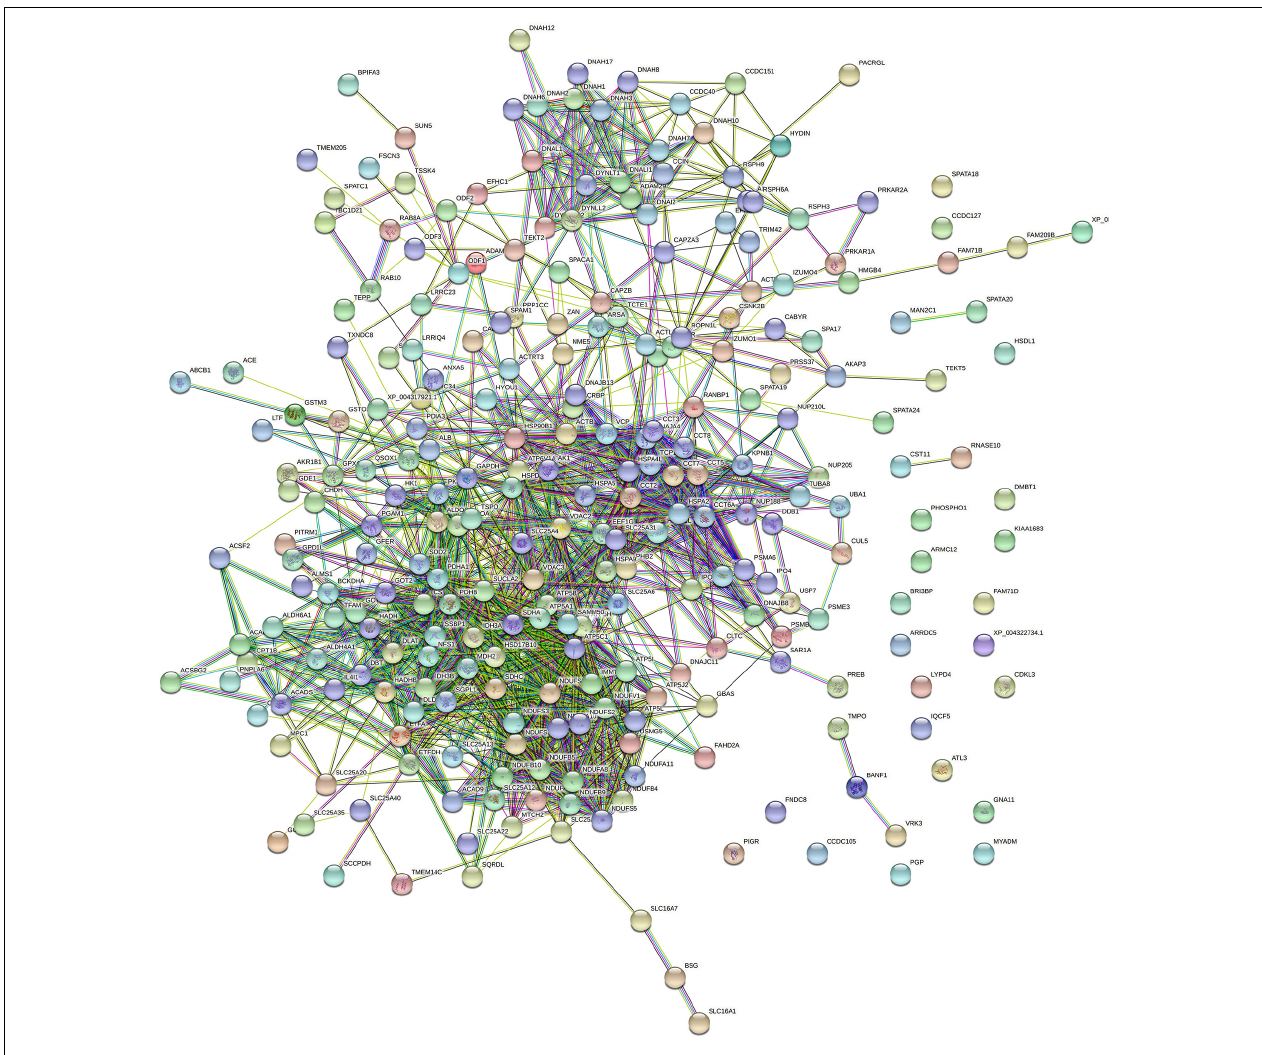
FIGURE 5 | STRING protein–protein interaction network showing the interactions of the spermatozoa proteins identified in bottlenose